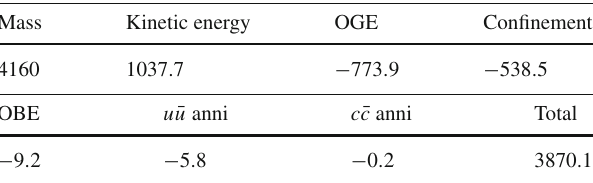
Table 8 The contribution from the terms of ChQM with the parameter set ‘ChQM new ’ and m g = 1 GeV (unit: MeV) Mass Kinetic